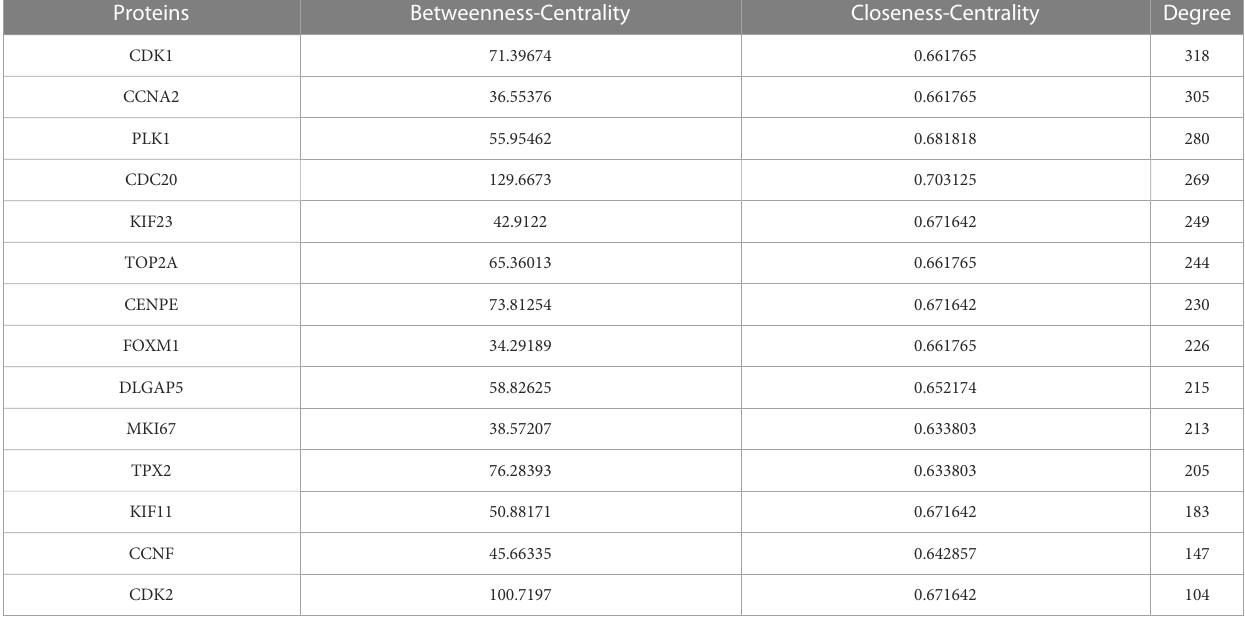
TABLE 1 Topological parameters of 14 preponderant